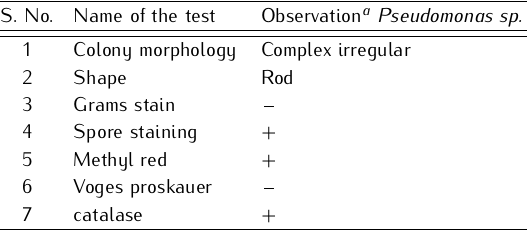
Table 3. Biochemical characterization of isolated